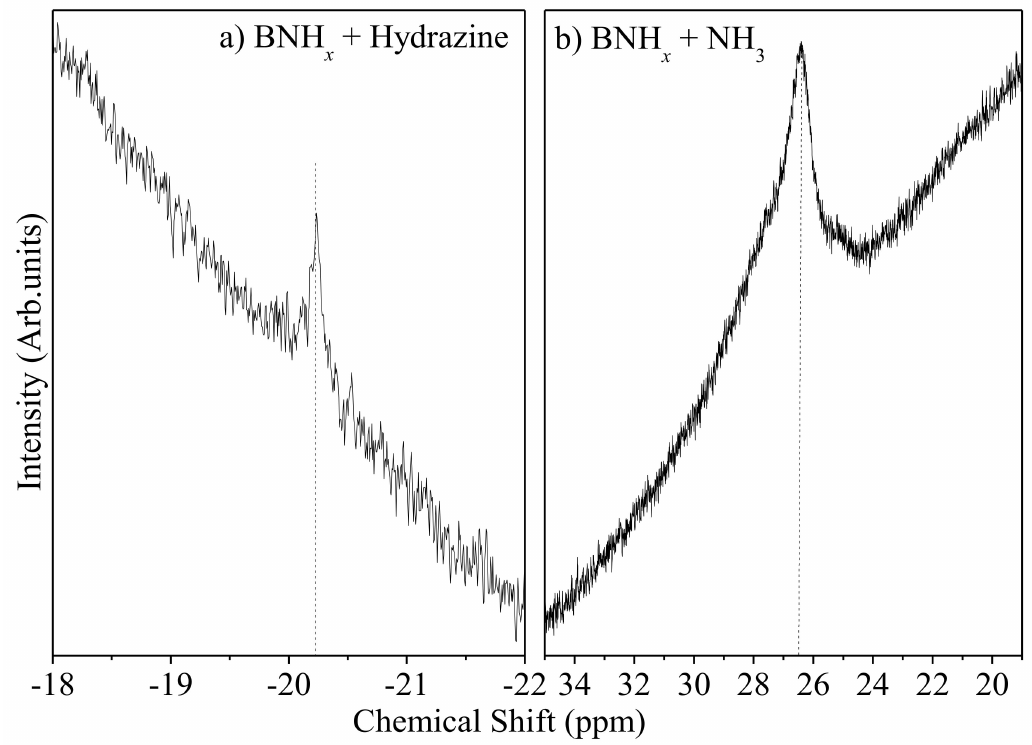
Figure 4. 11 B{ 1 H} solution NMR spectra of BNH x , after soaking in ( a ) N 2 H 4 and ( b ) liquid NH 3 (solvent: